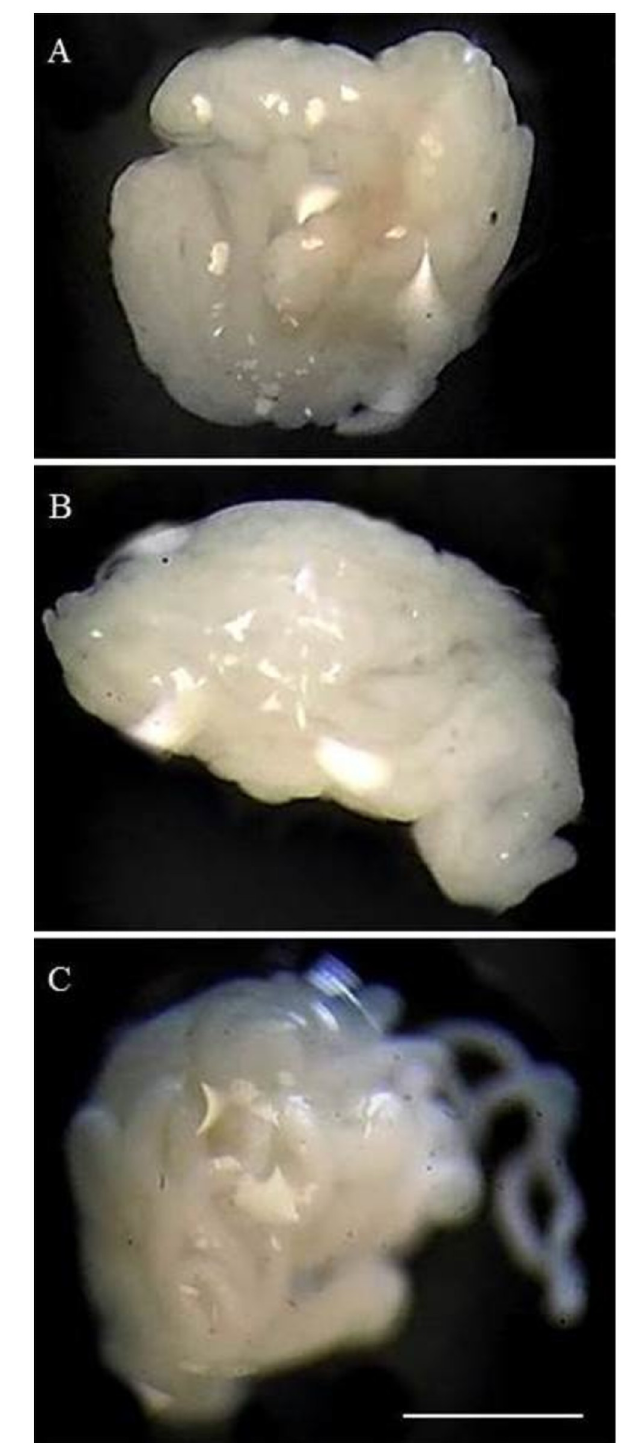
Fig 4. Testicles of adult male hybrids from the cross between T . b . macromelasoma female x T . lenti male (A), T . juazeirensis female x T . lenti male (B) and T . melanica female x T . lenti male (C). Note that the gonads do not have gonadal dysgenesis. Bar: 10 mm.